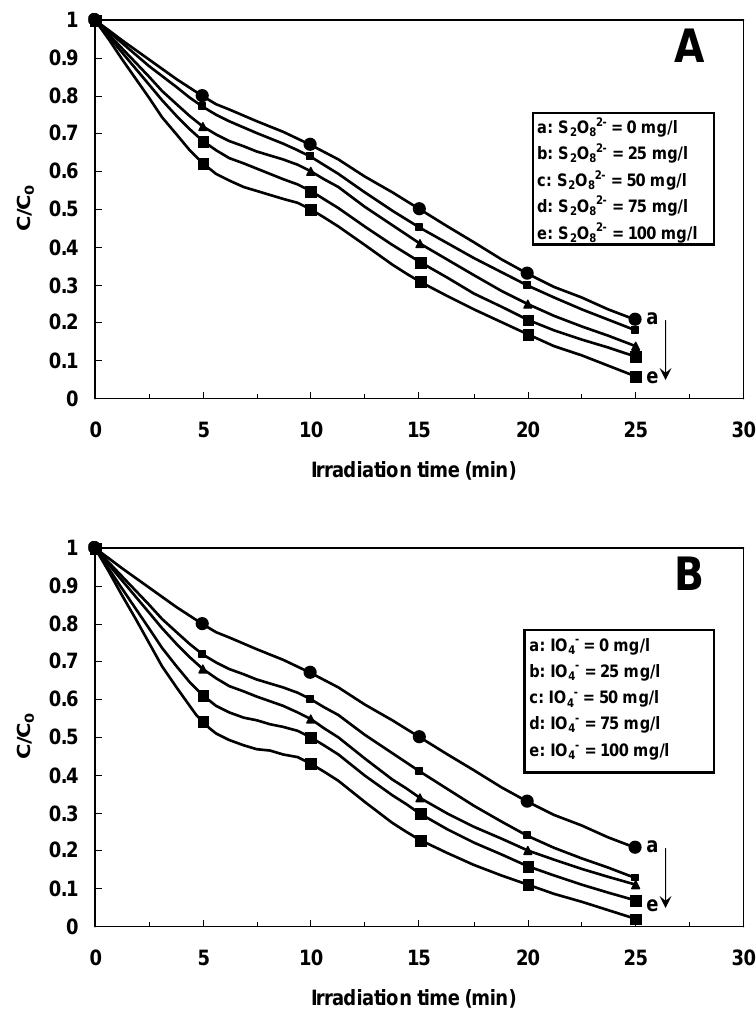
Fig. 8. Effect of addition of persulfate and periodate on the degradation of salicylic acid in solution containing 100 ppm salicylic acid in 0.1 M H